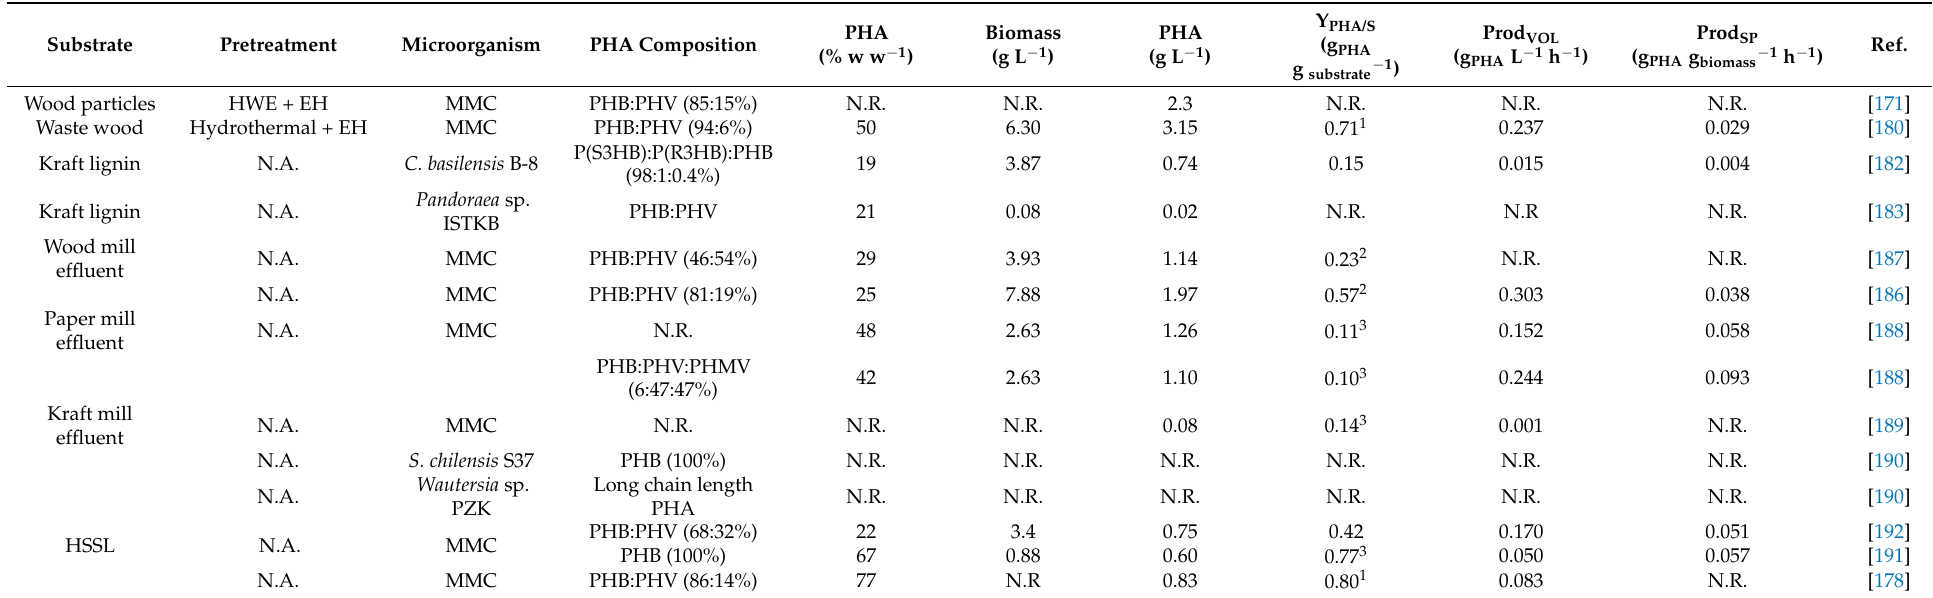
Table 2. PHA production from pulp and paper